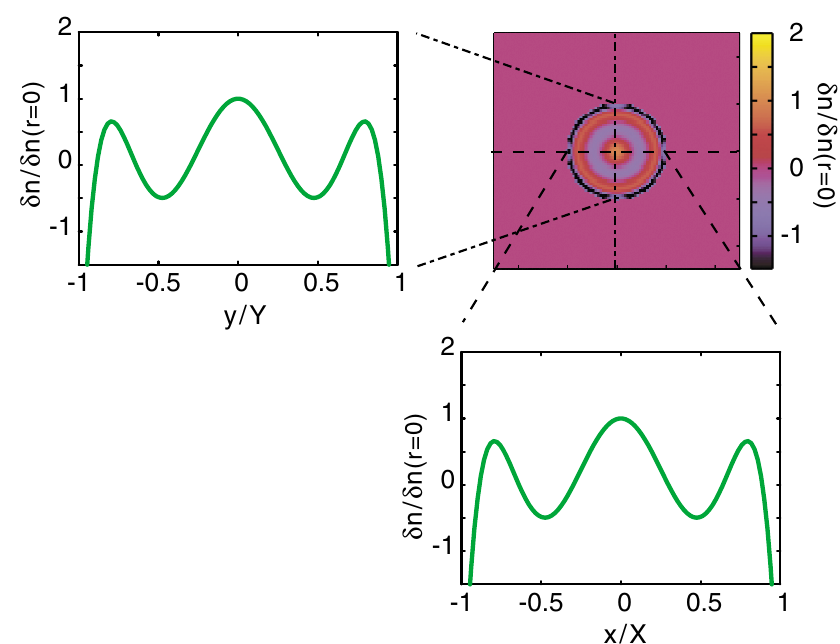
(cid:7) 45 r 4 =r 4 (cid:3) 35 r 6 =r 6 . Contour map shows b b b